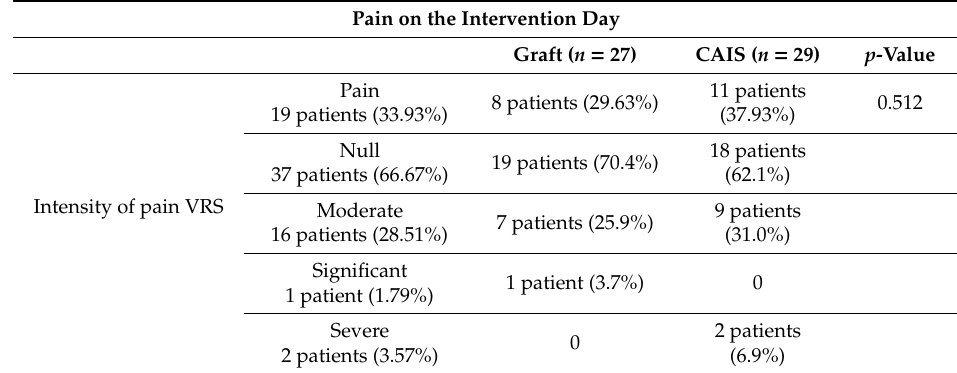
Table 3. Pain on the intervention day. VRS, verbal rating scale.